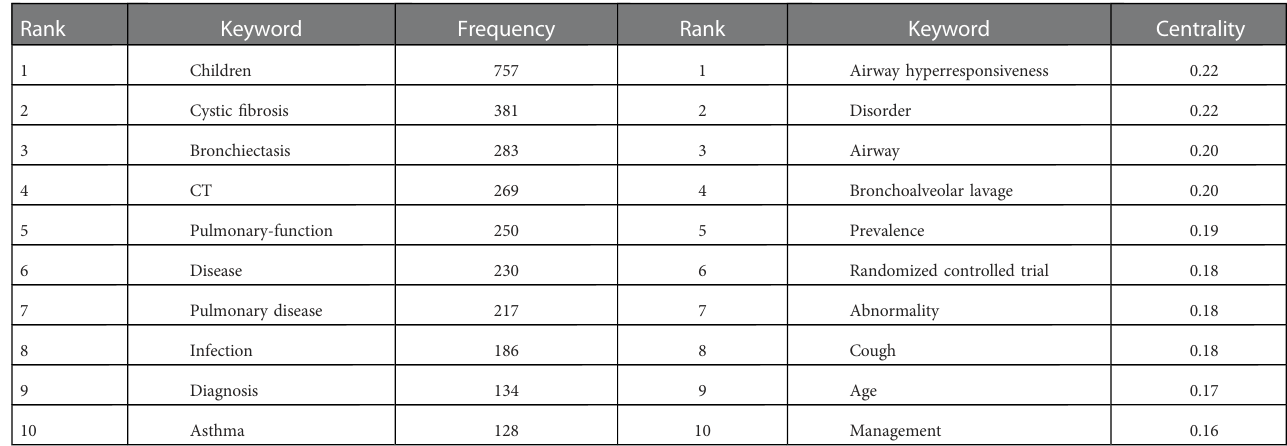
TABLE 4 Top 10 keyword co-occurrence frequency and centrality